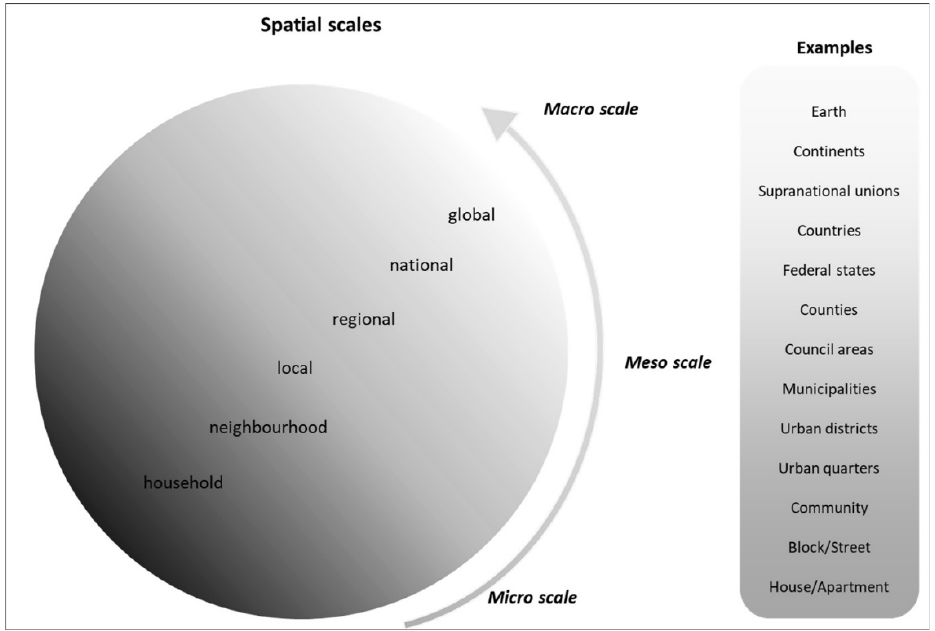
Figure 2. Spatial scales in